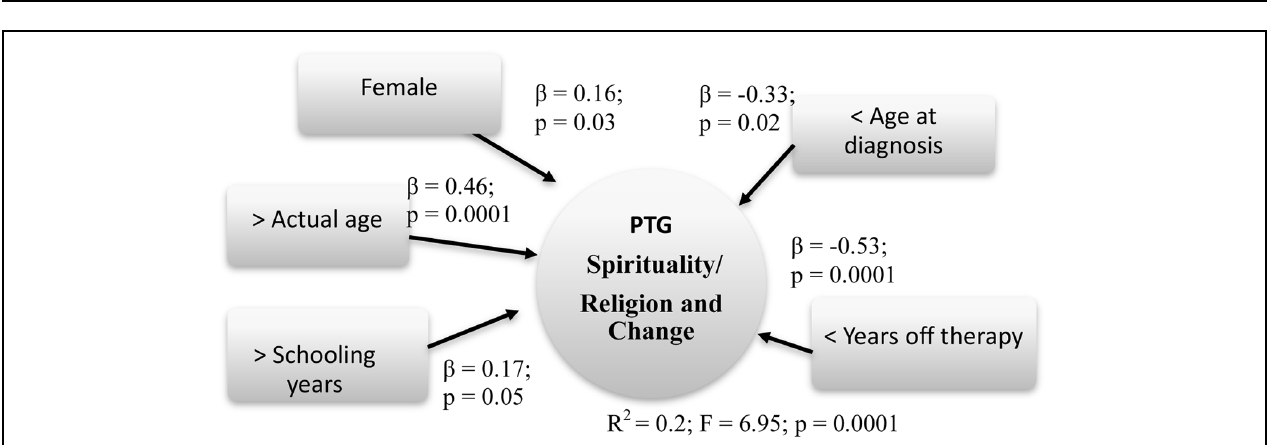
FIGURE 5 | Predictive factors of PTG relations and openness toward the world. Rectangle: stable Independent variables; Square: modifiable Independent variables; Circle: Dependent variables.